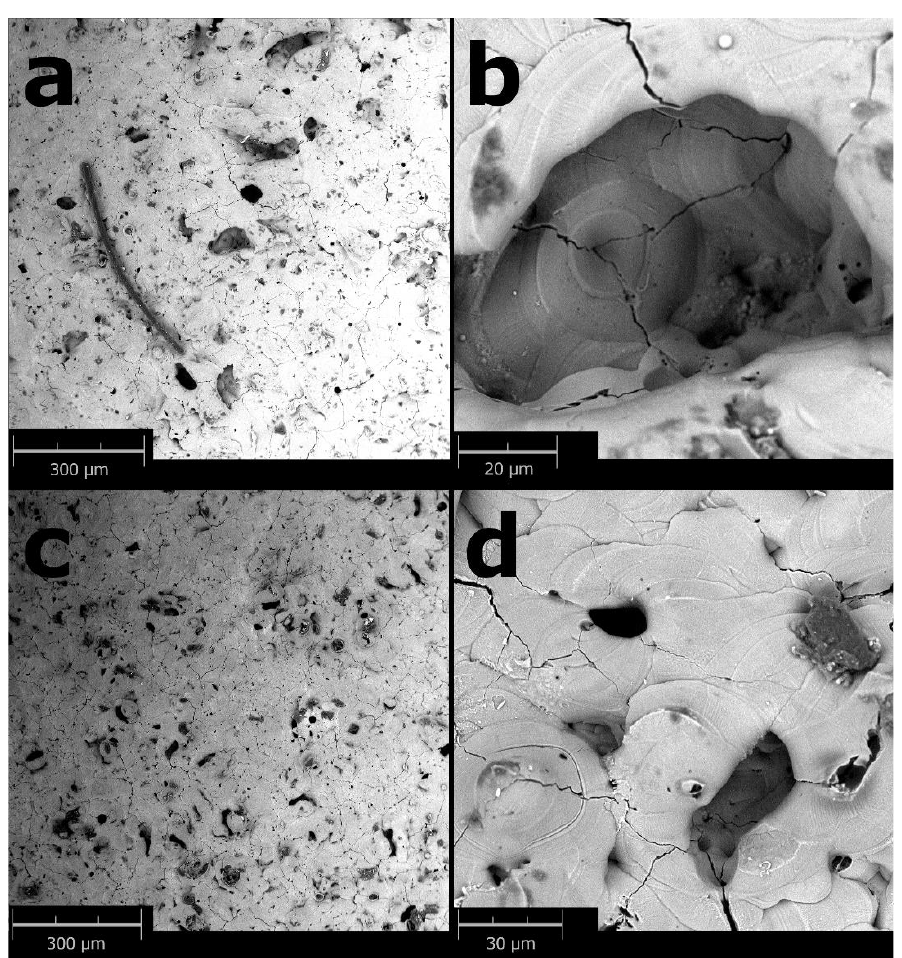
Figure 1. ( a , b ) Scanning electron microscope image of doped coating with different scales; ( c , d ) Scanning electron microscope image of undoped coating with different scales.